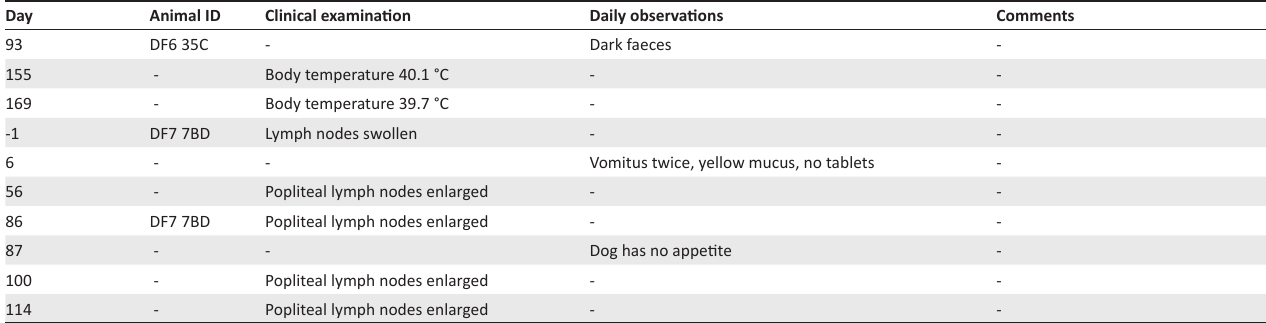
TABLE 6 (Continues...): Abnormal signs observed during clinical examinations and daily